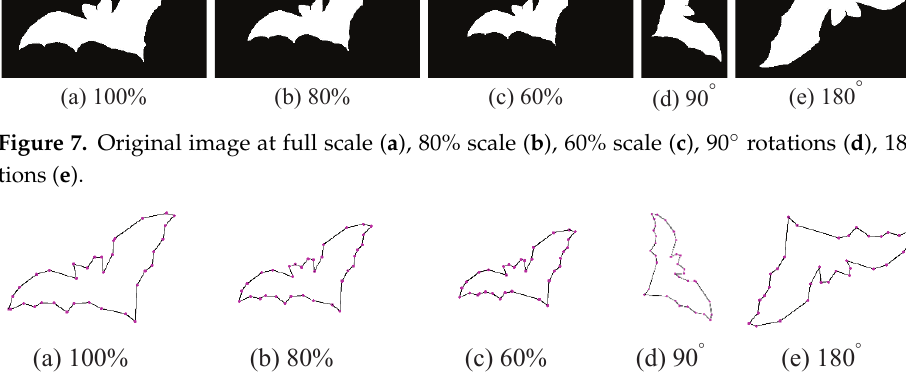
Figure 8. Approximation results of PSM algorithm on ( a ) original image at full scale, ( b ) original image at 80% scale, ( c ) original image at 60% scale, ( d ) original image at 90 ◦ clockwise rotations, ( e ) original image at 180 ◦ clockwise rotations.